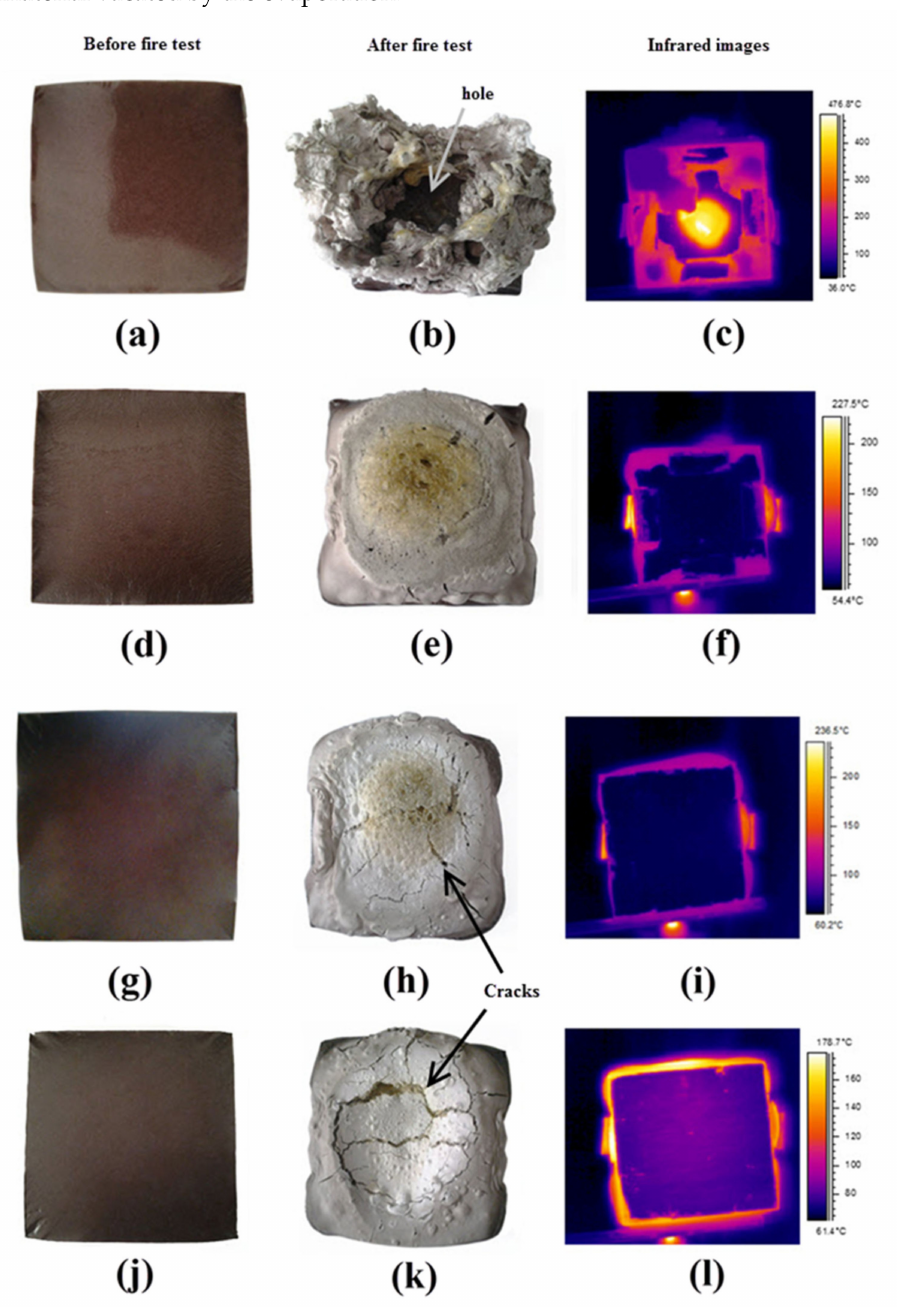
Figure 16. Images of RHA-based geopolymer binder and infrared images before and after fire- retardant test for samples S28 ( a – c ), S5 ( d – f ), S7 ( g – i ), and S23 ( j – l